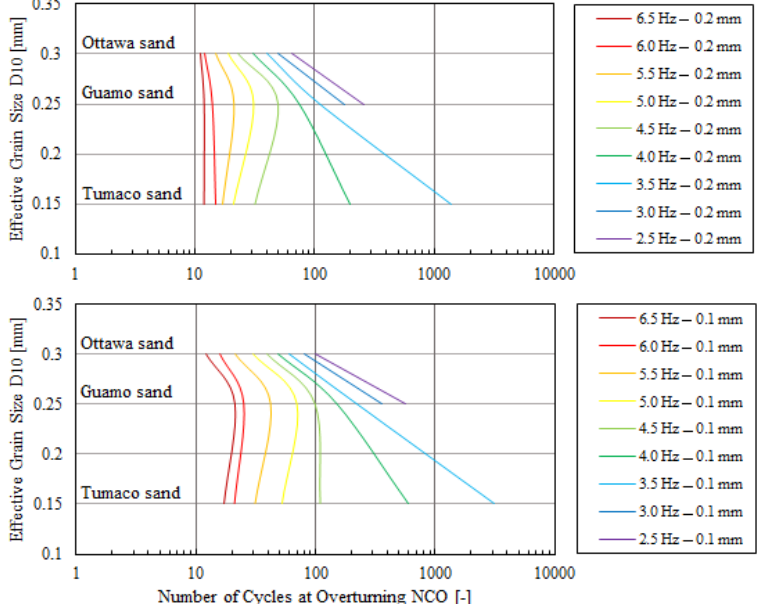
Figure 14. Number of cycles at overturning (NCO) versus effective grain size D 10 . It is possible to observe the influence of D 10 on the behavior of the sand samples subjected to specific excitation frequencies and vertical displacement amplitudes on the edge of the footing. For low excitation frequencies, the SDOFO did not experience overturning even after 10,000 cycles when testing Tumaco sand.